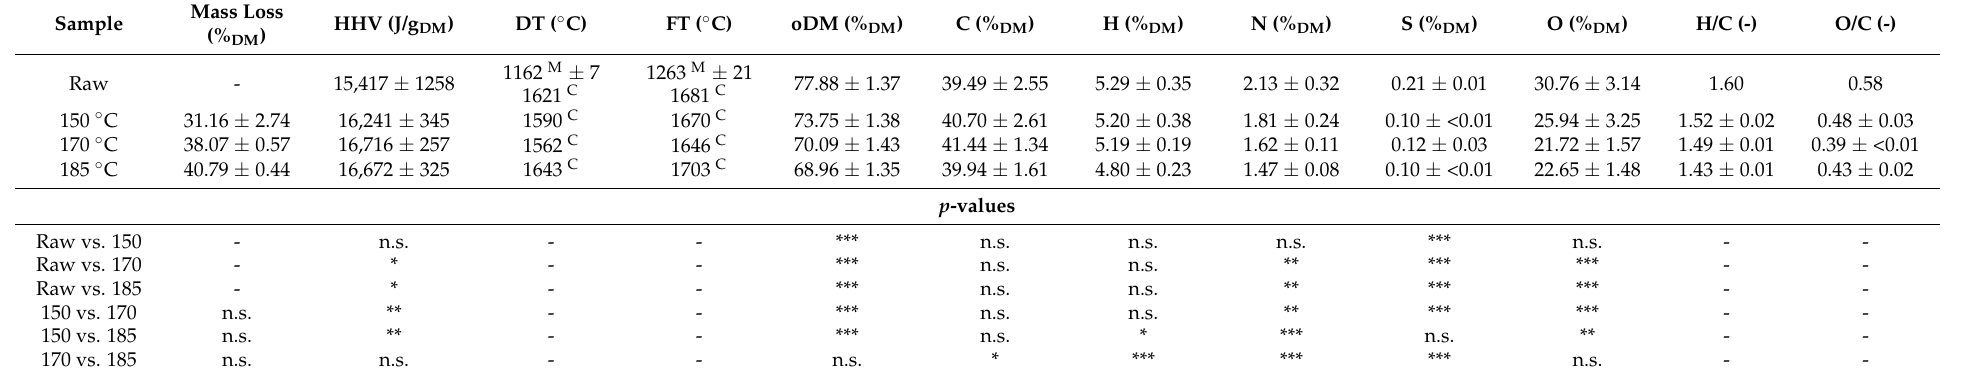
Table 2. Basic material properties (mean values ± standard deviation) including the level of significance for raw organic fractions of municipal solid waste (OFMSW) and hydrothermal- treated OFMSW (biochars) at 150, 170 and 180 ◦ C. Deformation temperature (DT) and flow temperature (FT), dry matter (DM), higher heating value (HHV), organic dry matter (oDM), not significant (n.s.), * ( p < 0.05), ** ( p < 0.01), *** ( p < 0.001).